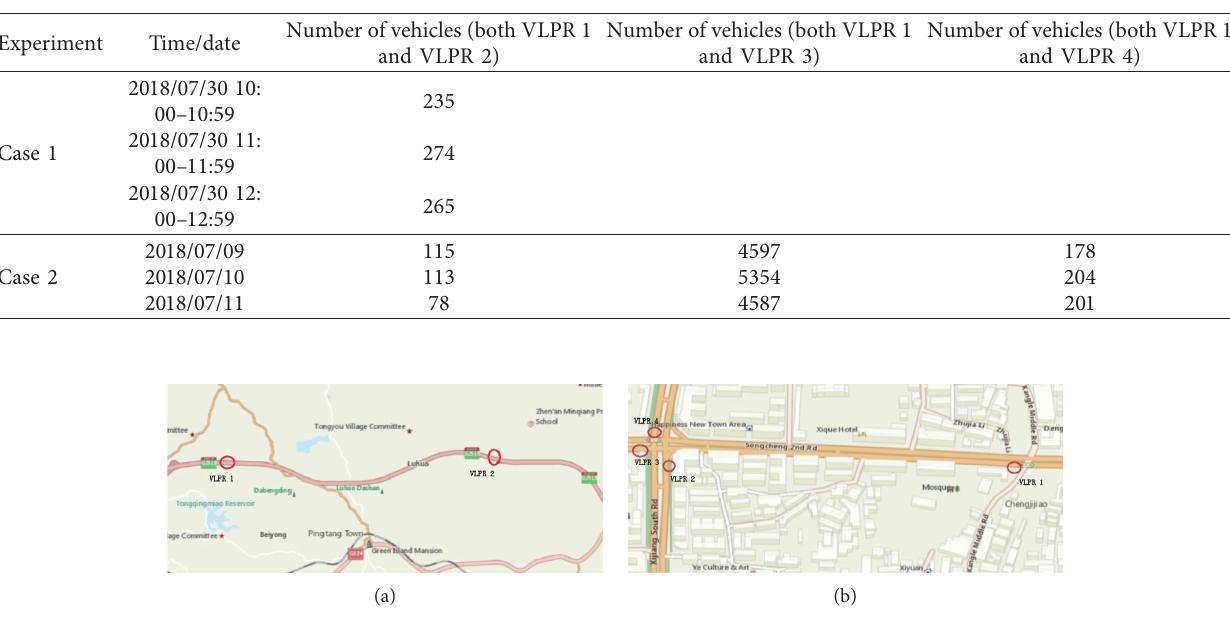
Table 5: The numbers of vehicles in Case 1 and Case 2.